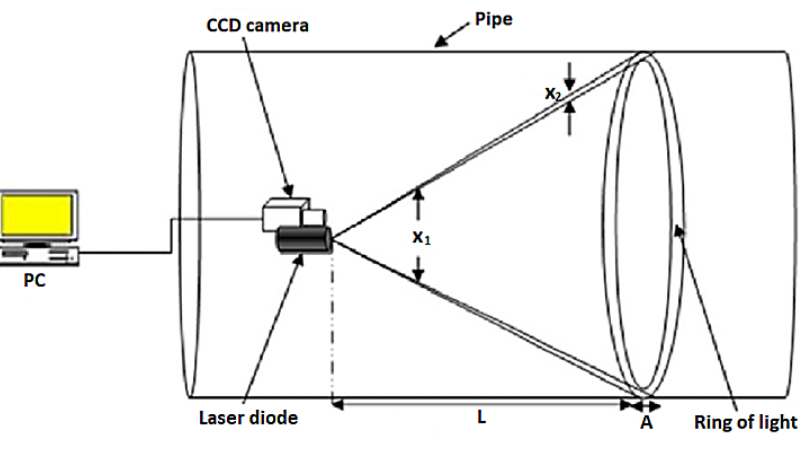
Figure 50. The projection of the laser beam in the form of a ring on the internal wall of a pipeline. Reprinted from NDT & E E International, Volume 52, Safizadeh, M.S.; Azzizadeh, T. Corrosion